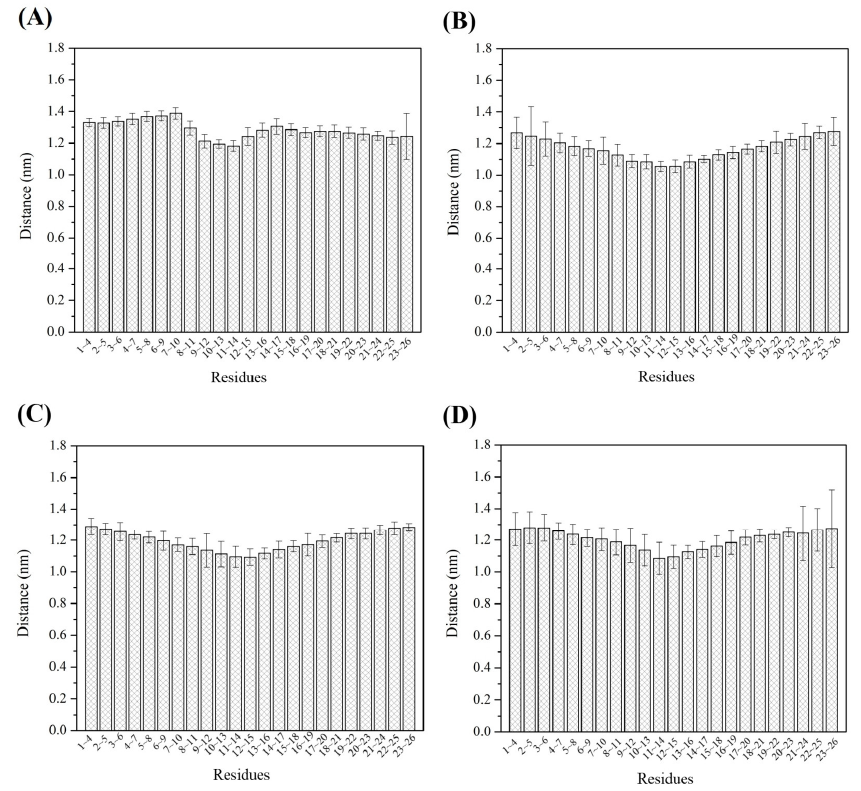
Figure 6. Atom distance of single amylose molecule ( A ), complex1 ( B ), complex2 ( C ), and complex3 ( D ).